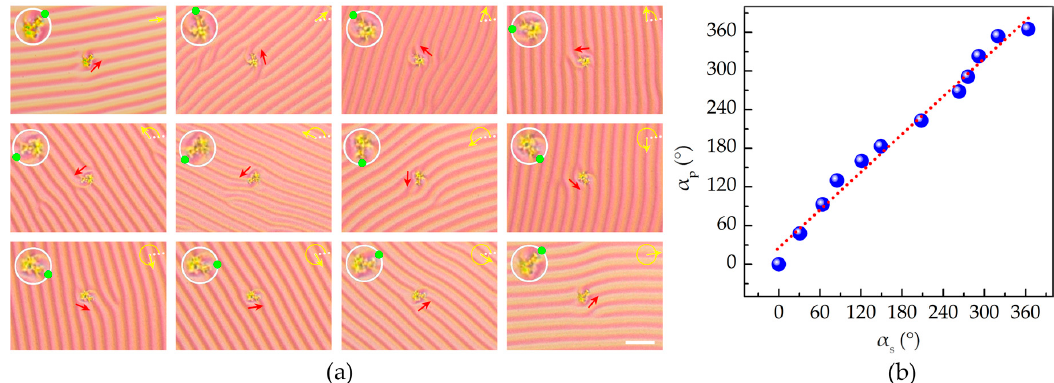
Figure 6. ( a ) Polarized optical microscope textures of the ZSM-5 zeolite microparticle rotation on the semi-free film. The enlarged microparticle is presented in the top left corner with a green dot denoting its orientation. The scale bar represents 25 μ m for all images. ( b ) Relationship between the rotational angle of the microparticle and that of the CLC grating. The dashed line is the linear fitting result.